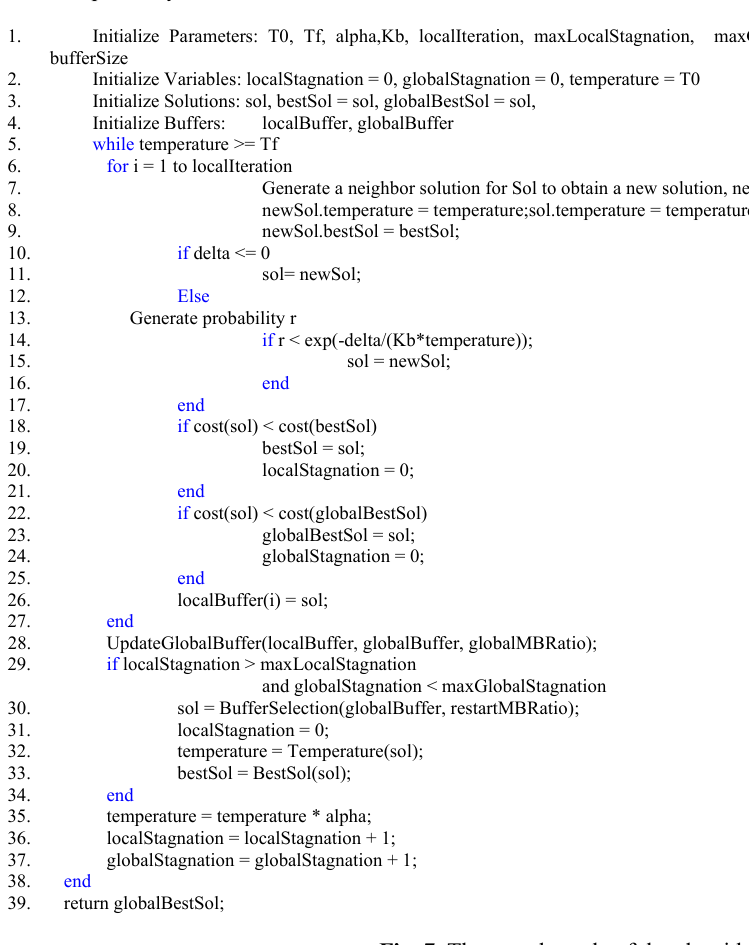
Fig. 7. The pseudo-code of the